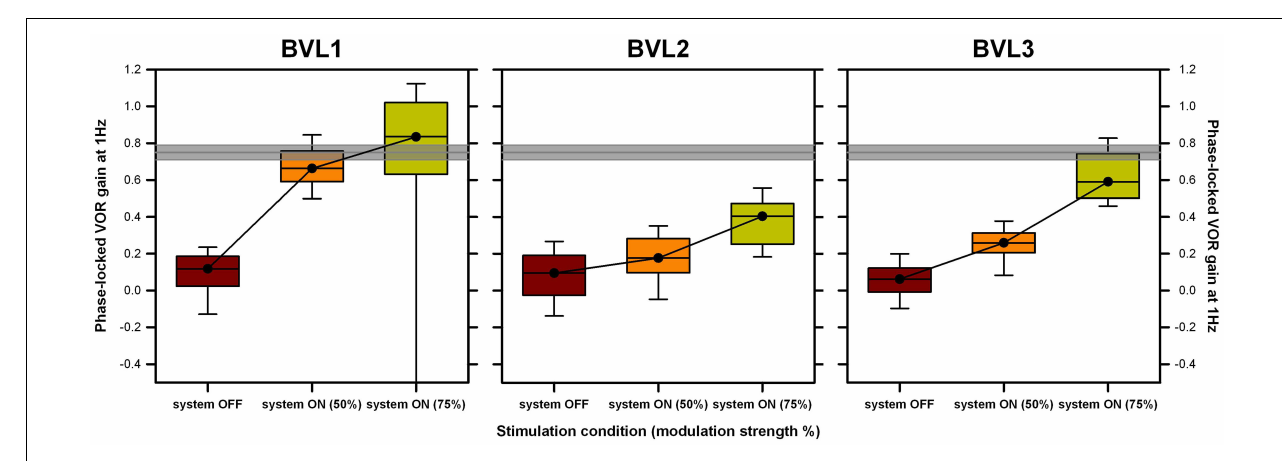
cycle-by-cycle basis. Box plots indicate median values, 25th and 75th percentile values (colored box) as well as 10th and 90th percentile values (error bars).The gray bar represents the mean ± SEM of theVOR gain measured in a group of five healthy subjects in the same experimental